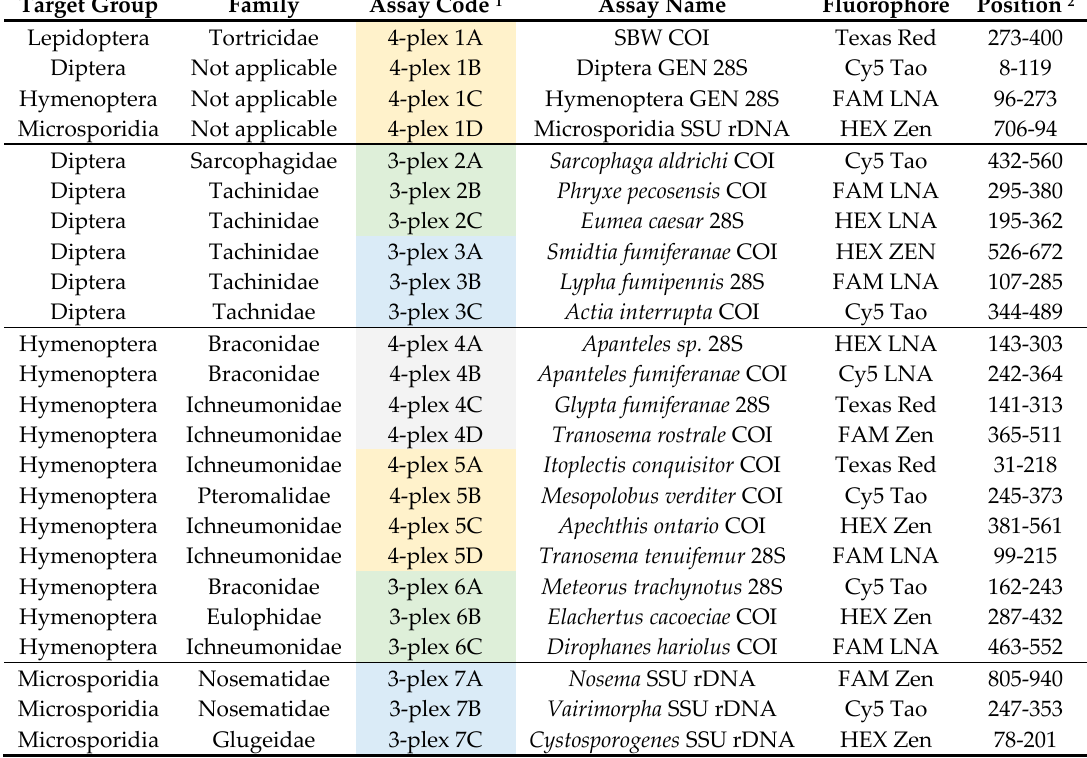
Table 2. List of individual assays built into the molecular sorting tool, including assay codes, targeted species, probe fluorophores, markers, and amplicon positions within markers. There are 24 assays run in 3-plex or 4-plex mode, in seven distinct